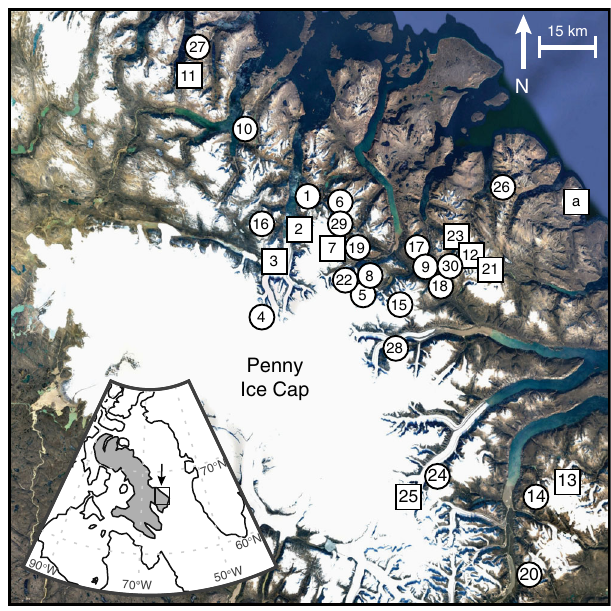
Fig. 1 Map showing sample localities on eastern Baf fi n Island. White circles indicate locations of plant samples, squares indicate locations with both plant and rock (in situ cosmogenic 14 C) samples. Site a is an unglaciated steep-sided summit where only rock was sampled (imagery: Google Earth: Image IBCAO,